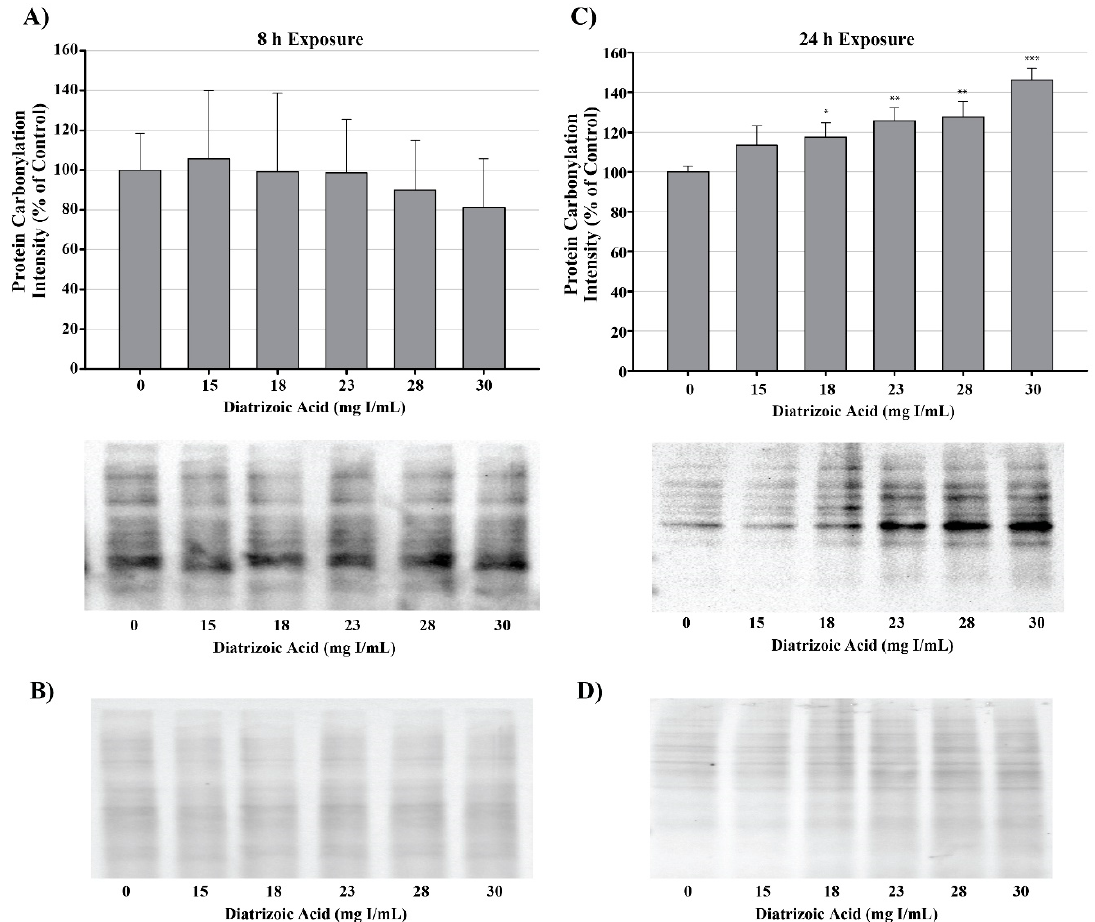
Figure 11. Diatrizoic acid effects on protein carbonylation in HK-2 cells . Carbonylated proteins were similar between control and DA treated cells at 8 h ( A ). DA at 18–30 mg I/mL increased protein carbonylation in cell lysate at 24 h ( C ). Memcode reversible stain for 15 µg protein depicted for 8 h ( B ) and 24 h ( D ) exposure. Statistical difference from 0 mg I/mL diatrizoic acid loading for gels is depicted by an asterisk (* p < 0.05, ** p < 0.01, *** p < 0.001). Values represent mean ± SEM for three independent experiments.